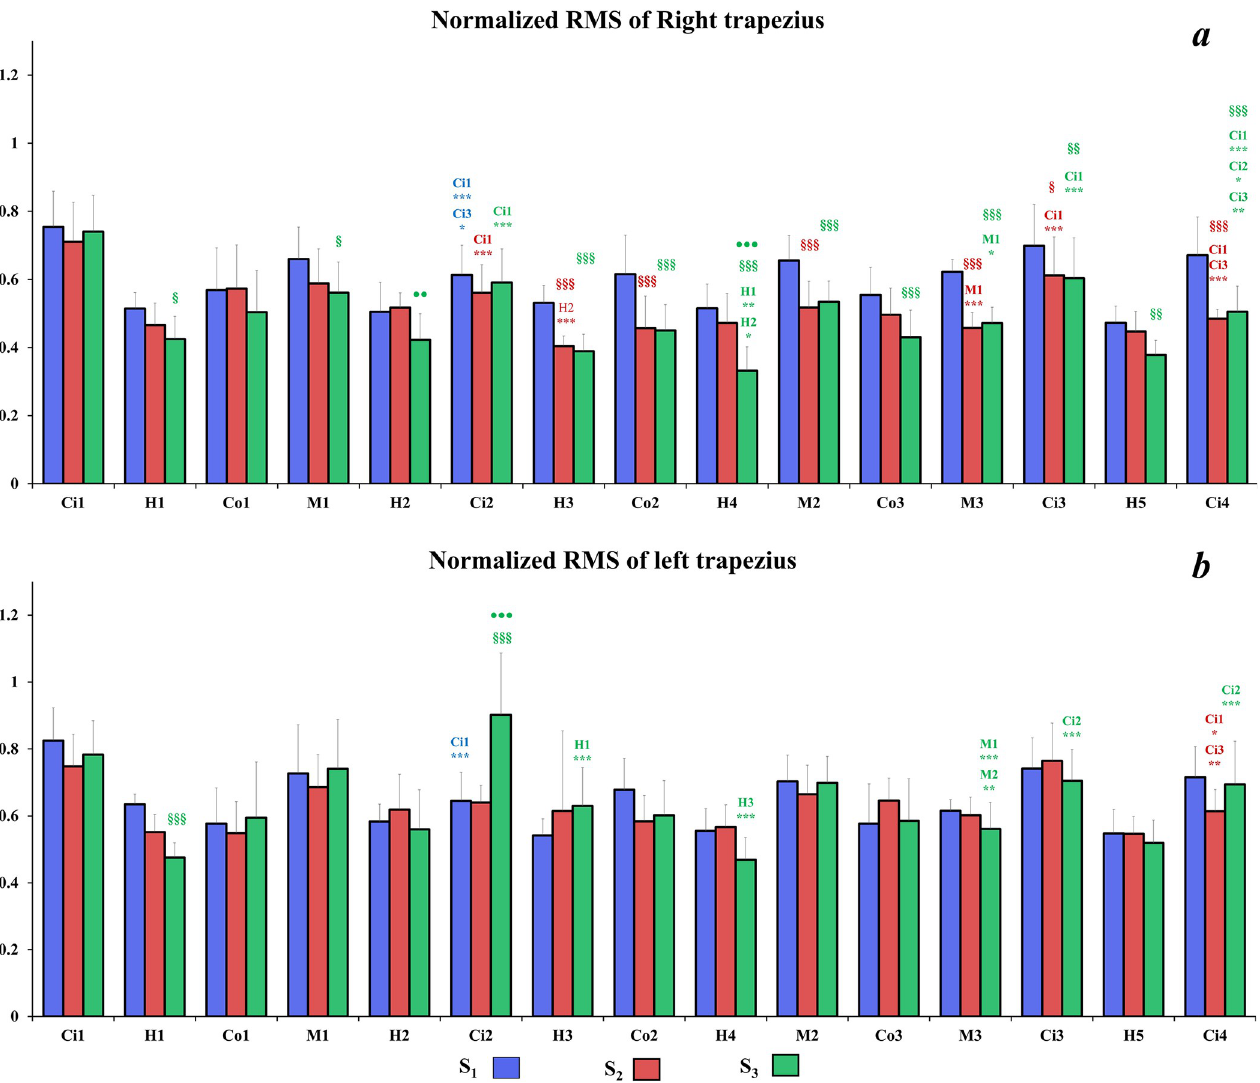
Fig 6. Mean of right (a) and left (b) TD normalized RMS values for each road sector for all seats. Significant differences between sectors of a same road type are symbolized by � (sectors concerned by the significant differences are mentioned above � ); significant differences between S 1 and other seats for a same road sector §; significant differences between S 2 and S 3 seats for a same road sector ●